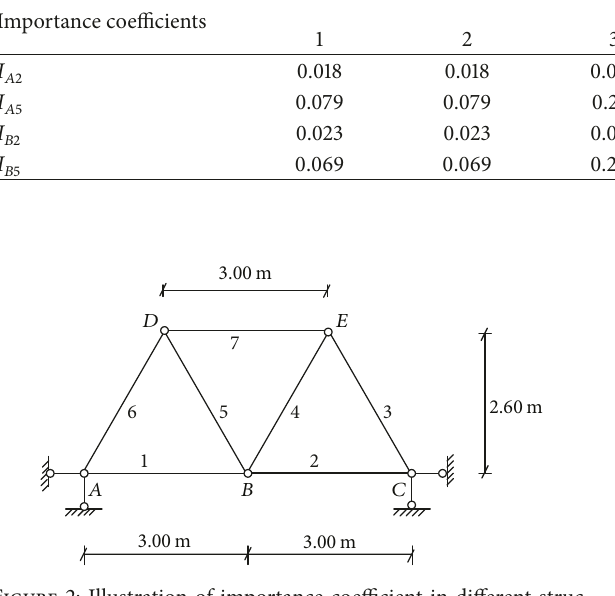
Figure 2: Illustration of importance coefficient in different struc-